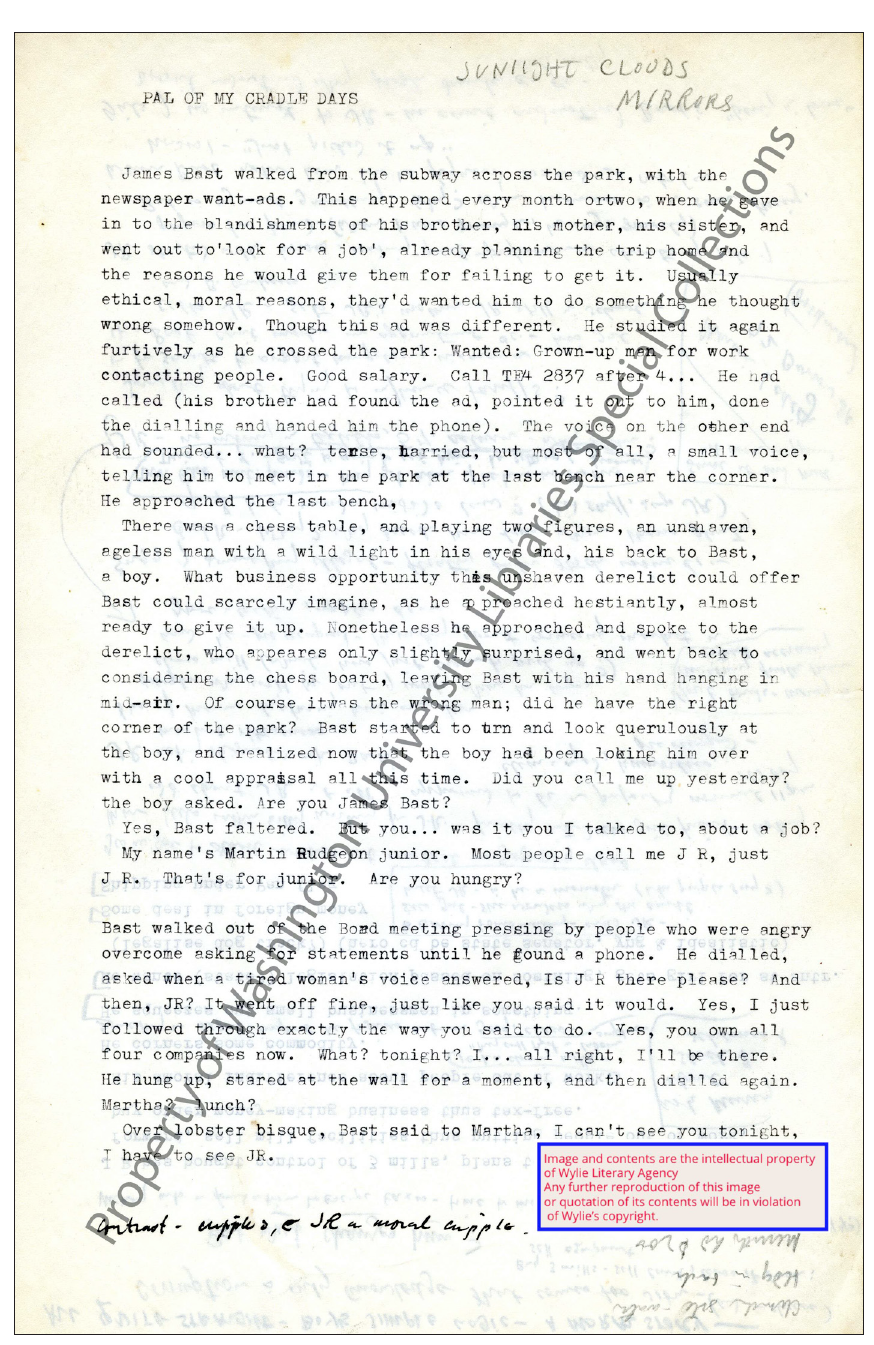
Figure 1: J R draft page in conventional